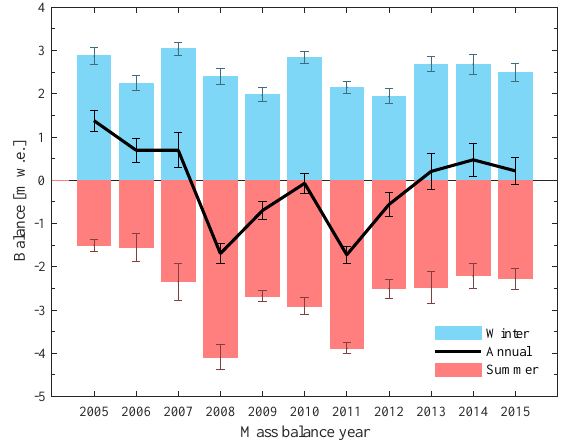
Figure 2. Record of glaciological mass balance for Brewster Glacier (Cullen et al., 2016). Error bars indicate 1 standard